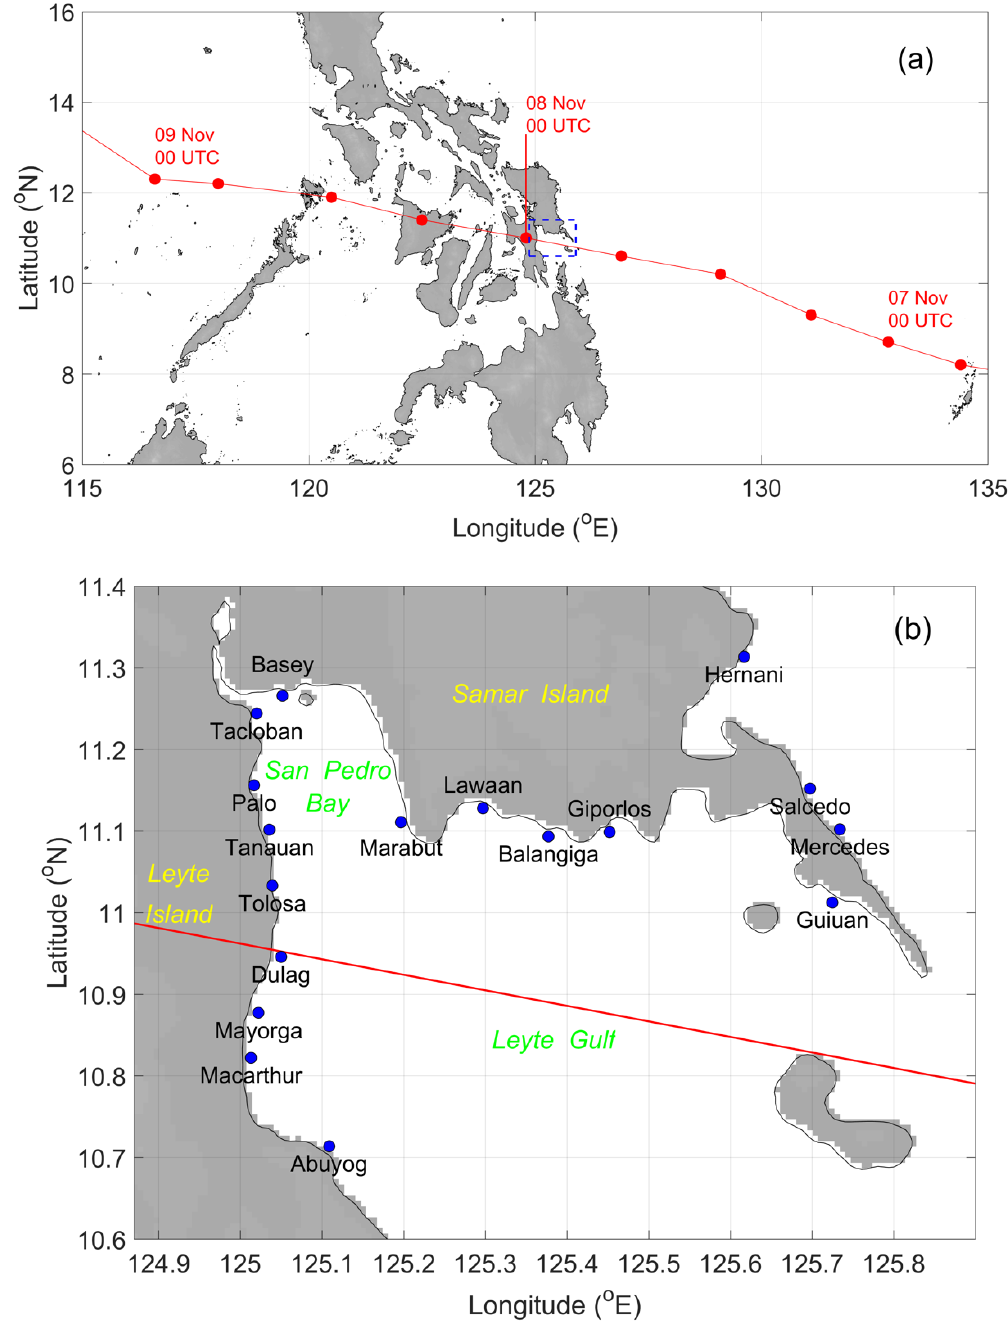
Figure 1. ( a ) Storm track of Typhoon Haiyan from the Japan Meteorological Agency (JMA) best-track database over the Philippines; ( b ) storm track of Haiyan in the Leyte Gulf and the San Pedro Bay. The grey shading depicts the land. The solid red circles indicate the locations of the storm center in every 6 h. The detailed information on the storm track refers to Table 1. The dashed blue box in Panel ( a ) denotes the area showing in Panel ( b ).